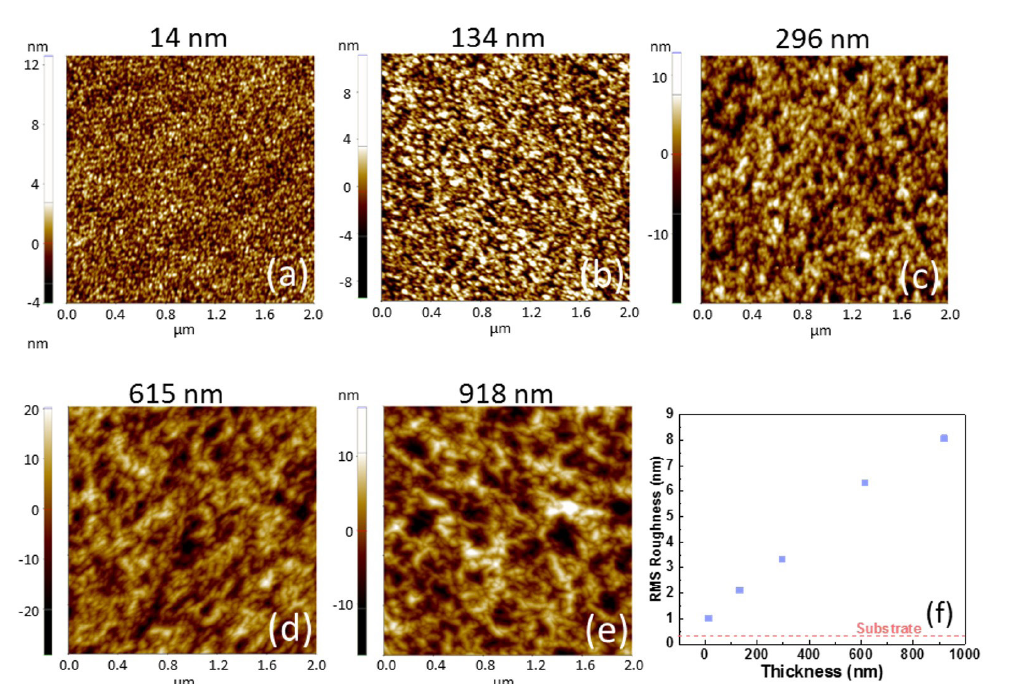
Figure 4. AFM images of samples of different thickness (a) 14 nm (b) 134 nm (c) 296 nm (d) 615 nm (e) 918 nm and their (f) RMS roughness. The roughness increases with increasing